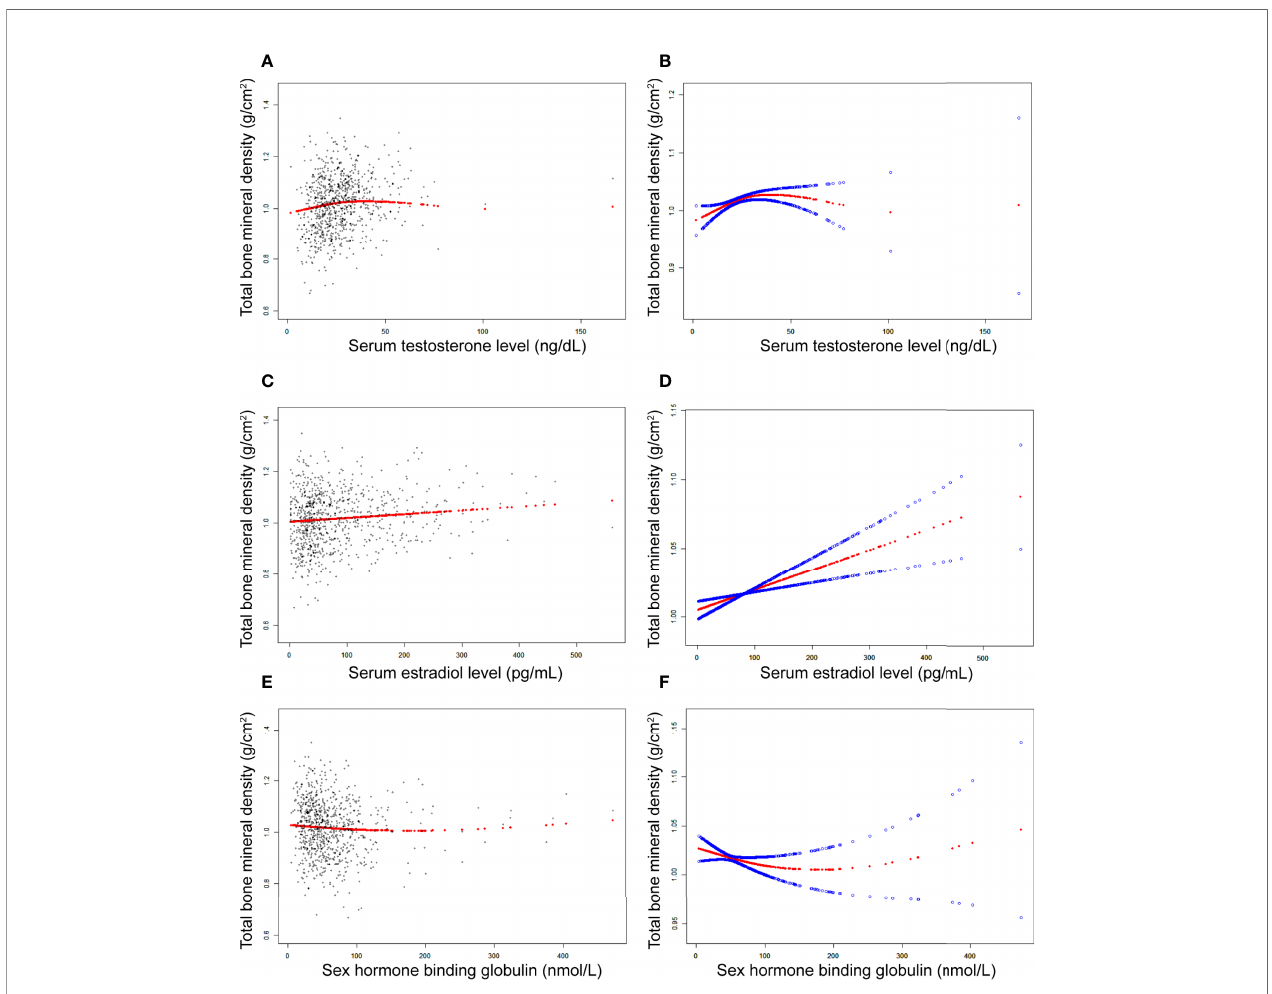
FIGURE 3 | The association between testosterone (A, B) , estradiol (C, D) , and SHBG (E, F) and total bone mineral density in girls, respectively. (A, C, E) Each black point represents a sample. (B, D, F) , Solid red line represents the smooth curve fi t between variables. Blue bands represent the 95% of con fi dence interval from the fi t. Adjusted for age, race, body mass index, ratio of family income to poverty, moderate activities, blood urea nitrogen, serum uric acid, total protein, total cholesterol, serum phosphorus, and serum